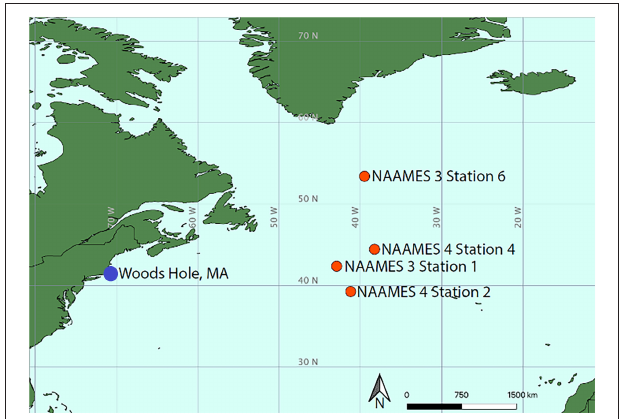
FIGURE 1 | Subset of NAAMES 3 and NAAMES 4 sampling stations. Sampling stations are indicated with red markers. The blue marker indicates the start and end point for NAAMES 3 and the end point for NAAMES